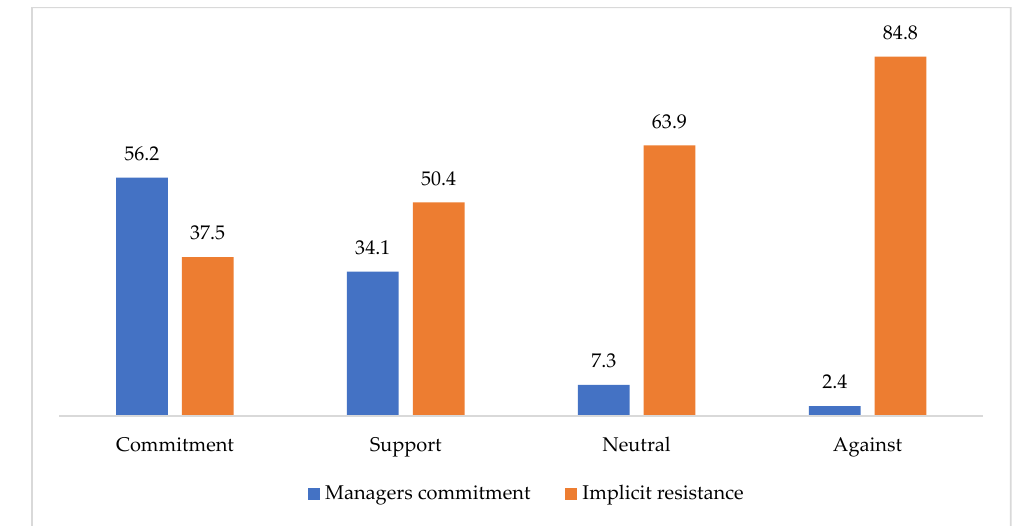
Figure 2. Prevalence of manager’s commitment and implicit resistance to prevent gender violence in organizations (%). Significant association between both categorical variables (likelihood ratio = 37.999, d.f. = 3, p < 0.001).